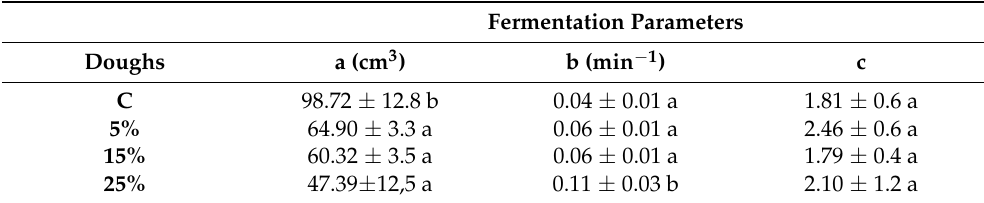
Table 6. Kinetics parameters obtained from modeling curves of dough fermentation. Dough: wheat flour (control: C) and blends of wheat flour and oat flour at 5, 15, and